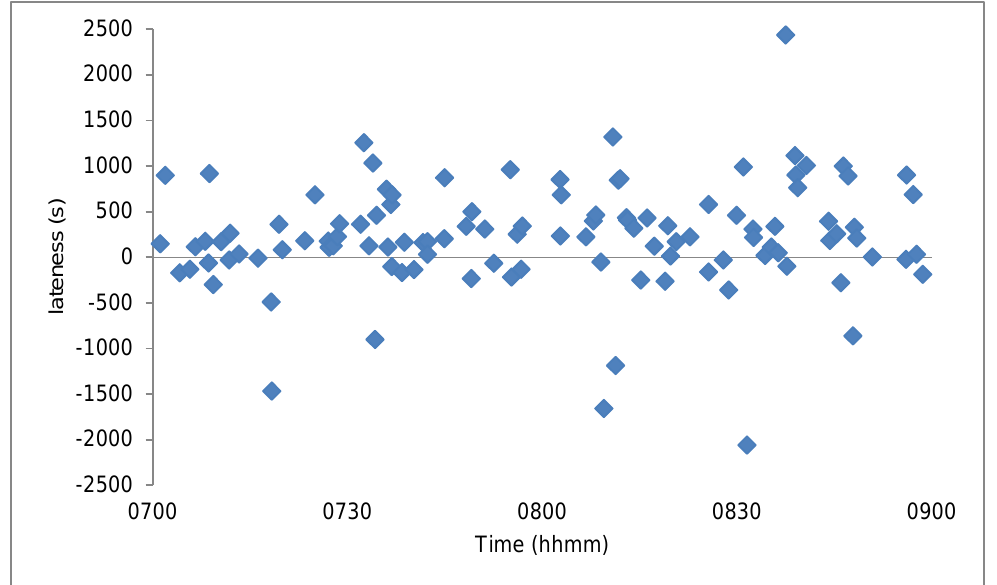
Figure 6. Lateness of regular vehicles (N ≥ 30, σ≤ 10) at site #11, northbound on 23/7/13